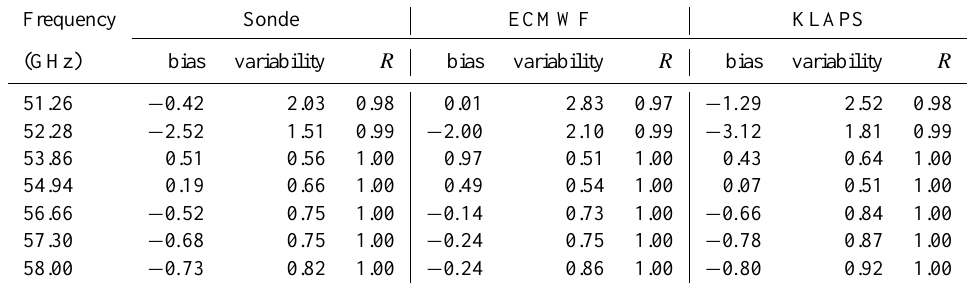
Table 3. The comparison results of the different simulated T b s and observed T b for clear and well-calibrated conditions for only when the radiosonde data is available (total of 26 cases). Frequency Sonde ECMWF KLAPS (GHz) bias variability R bias variability R bias